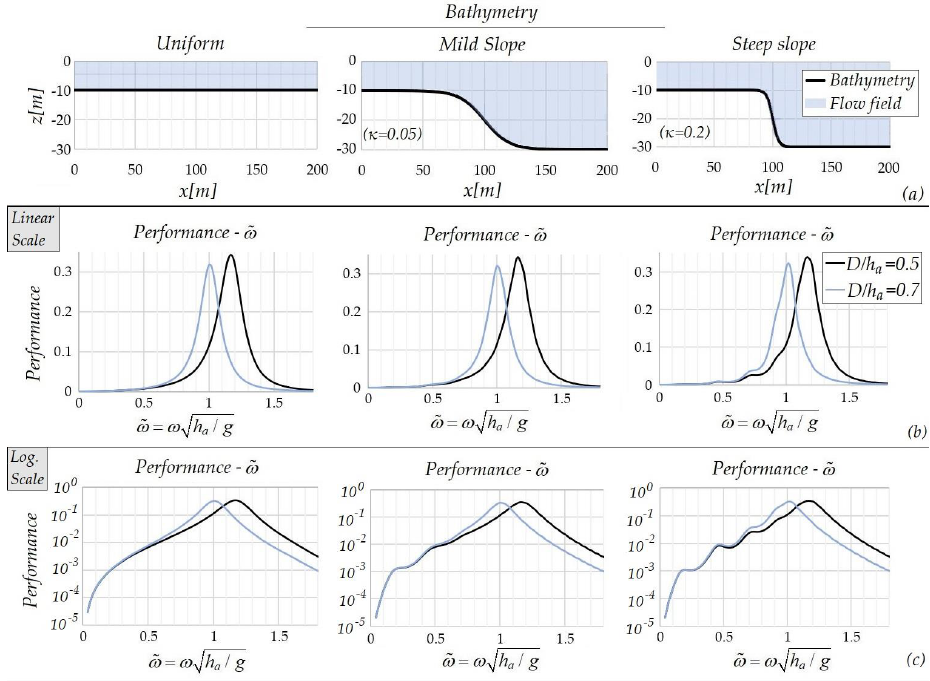
Figure 5. OWC performance curves in variable bathymetry (smooth shoals). ( Parameters : h b = 30 m , b = 3 m , h c = 7 m , d = 0.5 m , (cid:101) λ = − 1.4 )